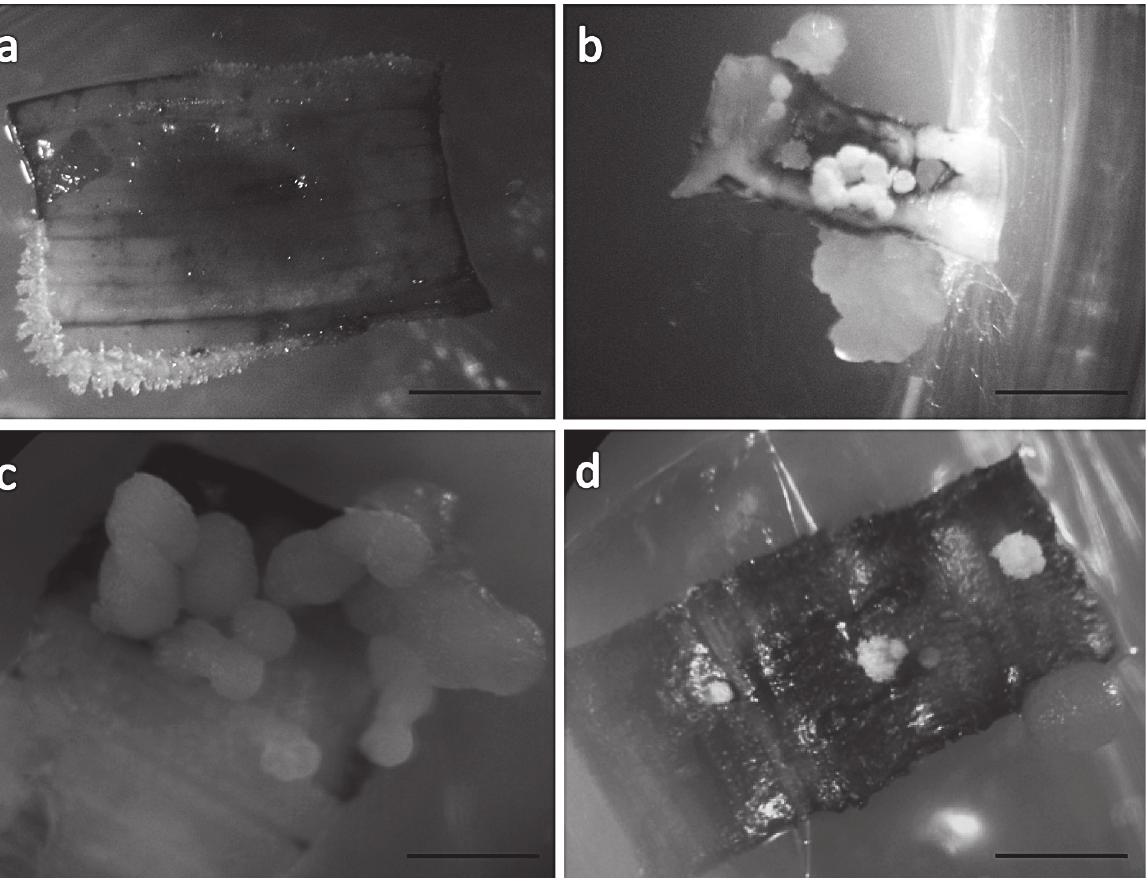
Figure 2 - Stereomicrographs of callus produced on oil palm tenera hybrid ( Elaeis guineensis ) leaves. A) Type 1 - elongated and translucent; B) Type 2 - uneven and translucent; C) Type 3 - globular and beige; D) Type 4 - globular and white. Bar = 0.25